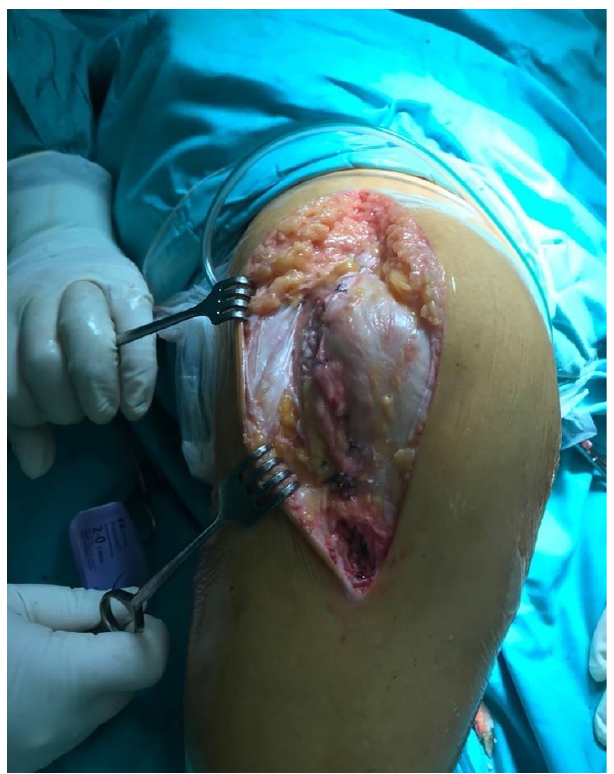
Figure 6. Closed joint capsule. Hoffa fat pad incorporated in the distal pole of the wound.